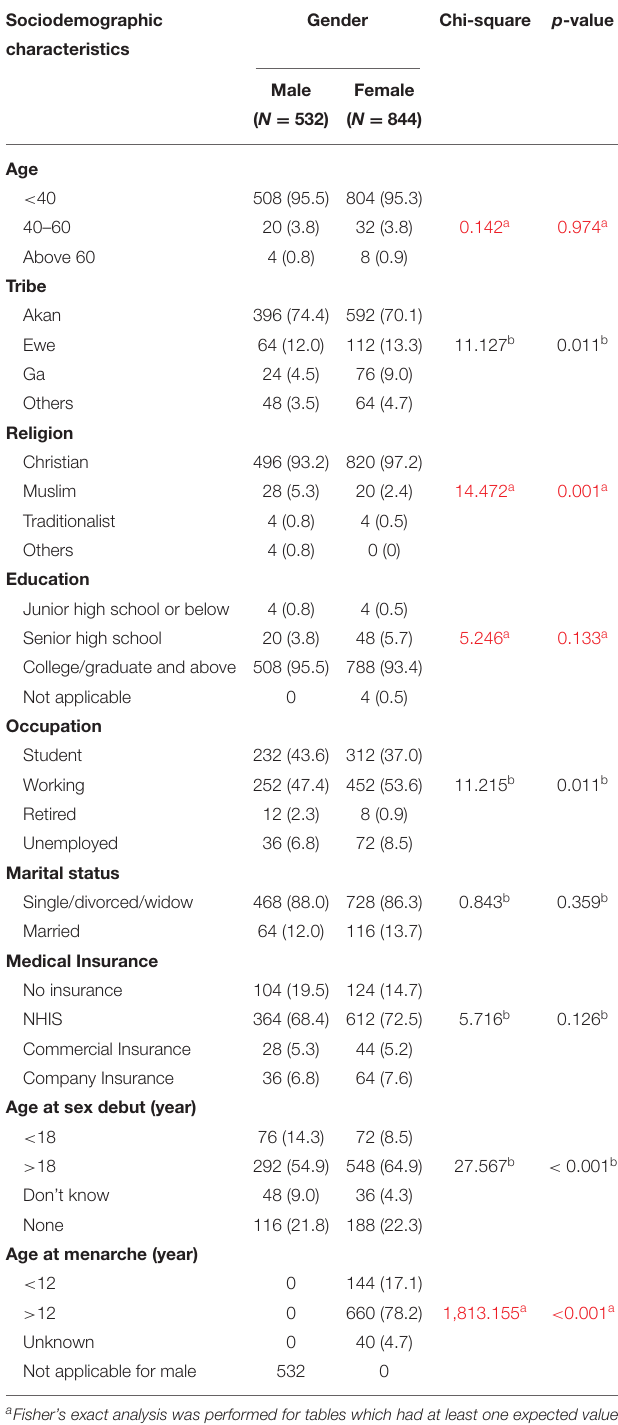
TABLE 1 | Sociodemographic characteristics of